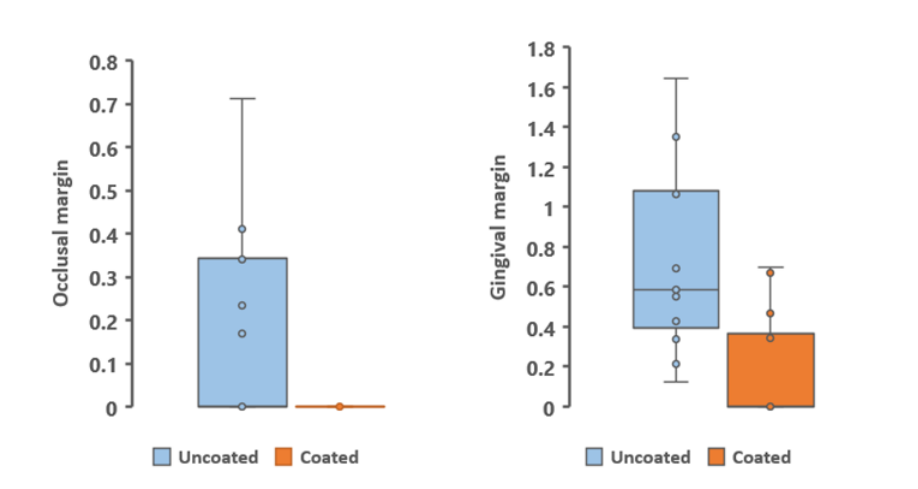
Figure 1 : Microleakage in millimeters of coated and uncoated groups represented by box and whisker